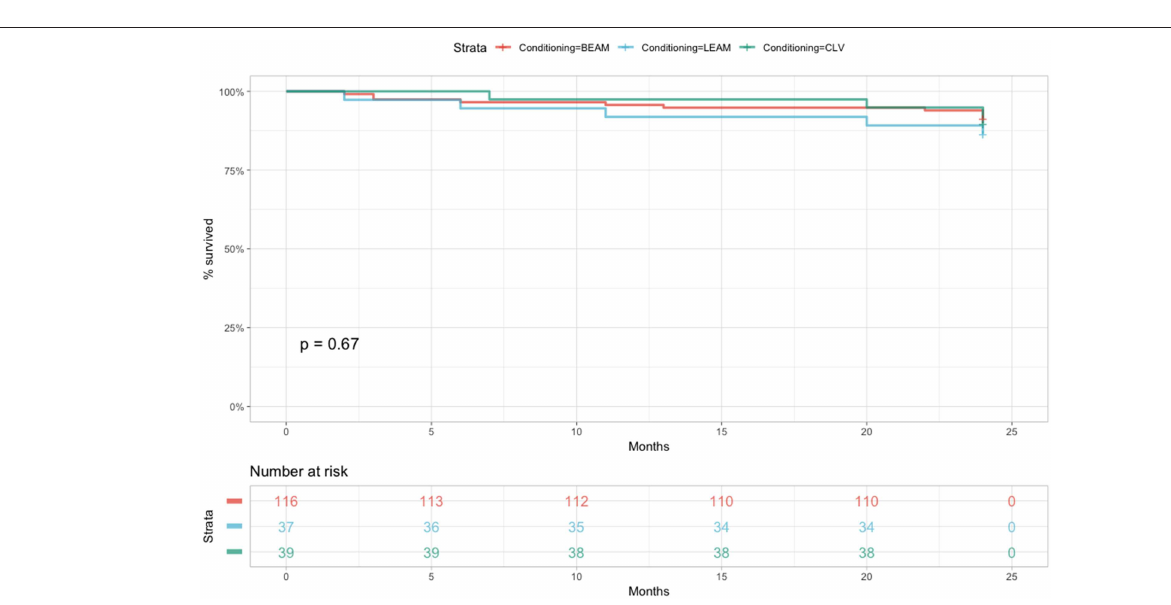
transfusion (HR = 3.58, 95% CI 1.26–10.17, p = 0.017)